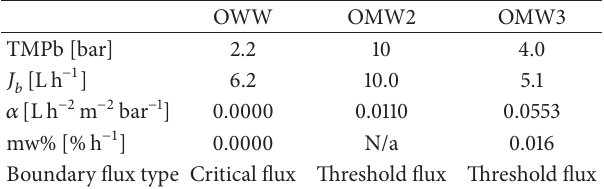
Table 4: UF boundary flux values for OWW, OMW2, and OMW3.